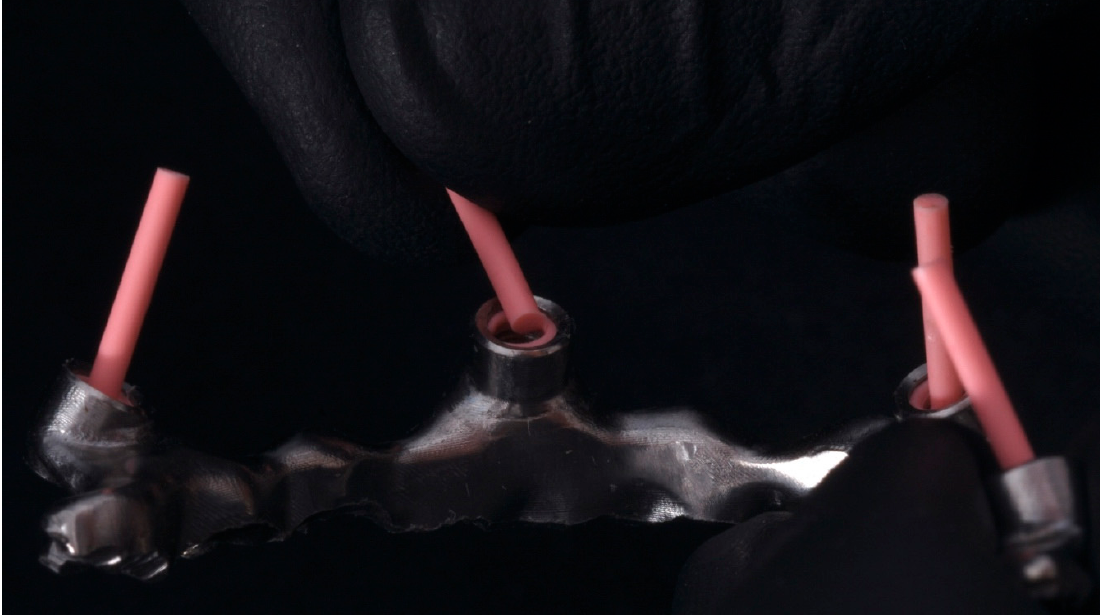
Figure 11. The titanium bar with the Seeger rings for OT Bridge system.